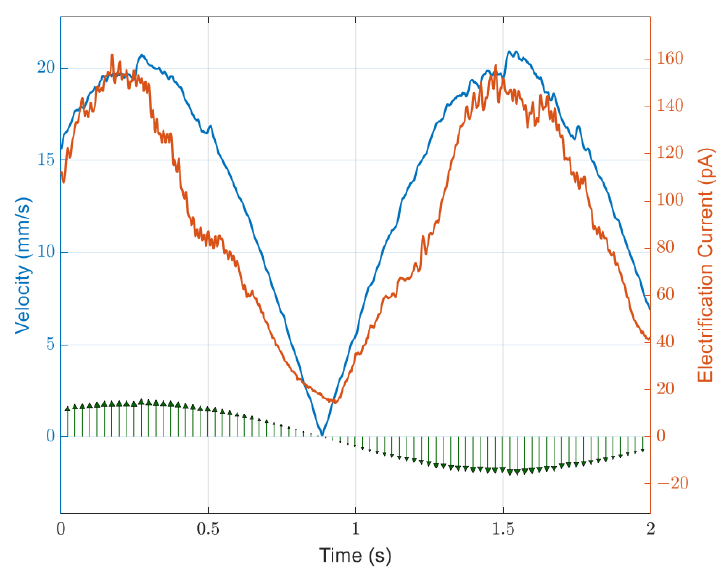
Figure 6. Intermittent shuttle velocity signal and generated electrification current. The top electrode swings with a frequency of 0.4 Hz. The black arrows correspond to the actual direction of movement over time while the blue line is the absolute value of velocity to show the correlation between the absolute velocity and generated electrification current.